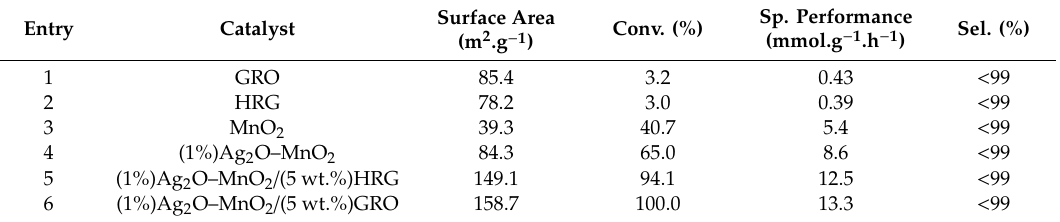
Table 1. Catalytic oxidation of BnOH, catalyzed by di ff erent catalysts.